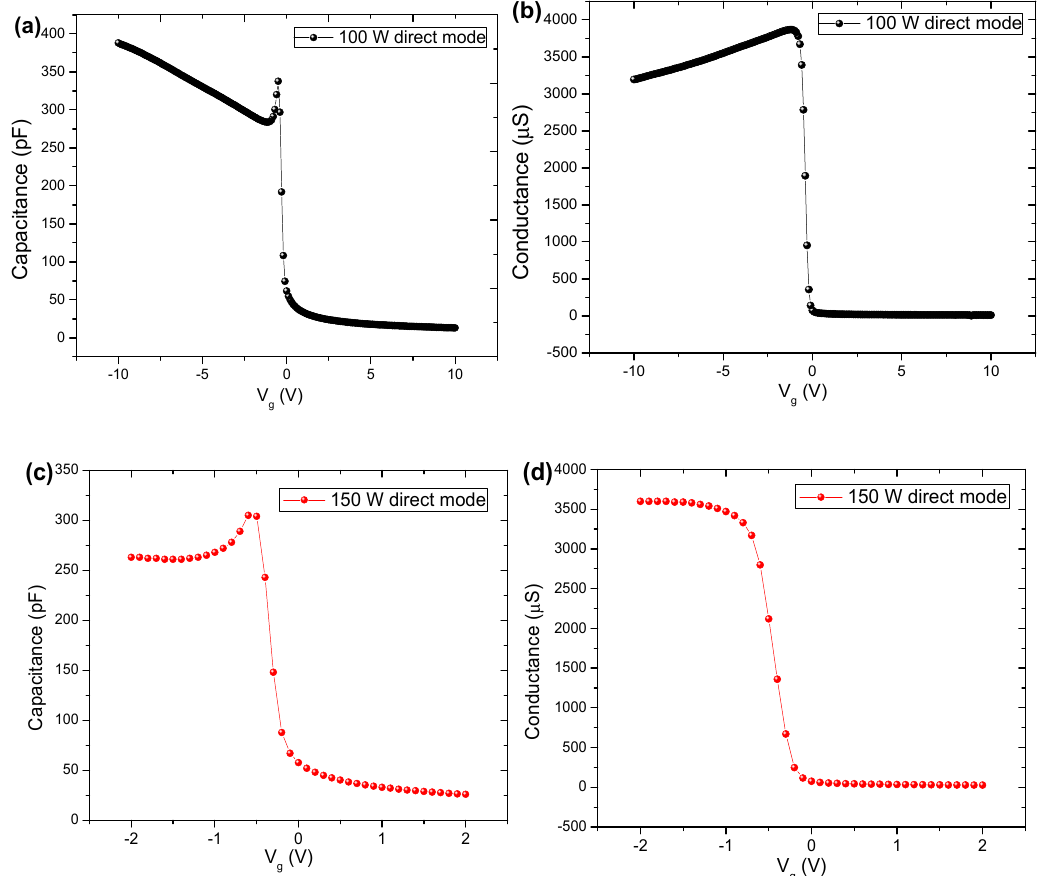
Figure 9. C-V and G-V curves for the fabricated MOS capacitors: ( a ) C-V curve for TiO 2 film grown in direct mode at 100 W, ( b ) G-V curve for TiO 2 film grown in direct mode at 100 W, ( c ) C-V curve for TiO 2 film grown in direct mode at 150 W and ( d ) G-V curve for TiO 2 film grown in direct mode at 150